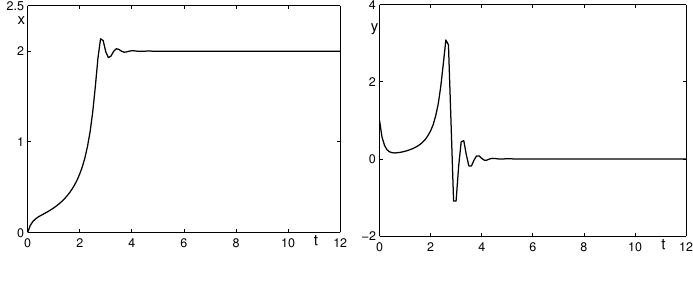
Figure 3. Time response of the Duffing system after gradient